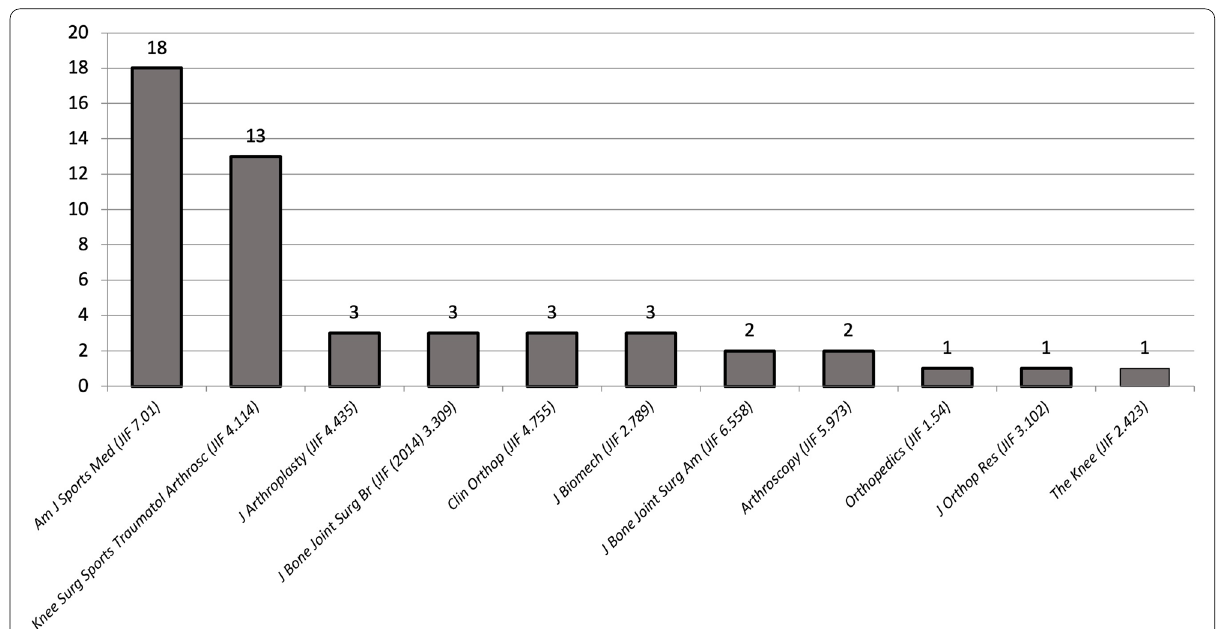
Fig. 2 Distribution of the top 50 studies by the journals of publication and their Journal Impact Factor of 2021 (JIF). American Journal of Sports Medicine (Am J Sports Med), Knee Surgery, Sports Traumatology, Arthroscopy (Knee Surg Sports Traumatol Arthrosc), Journal of Arthroplasty (J Arthroplasty), Journal of Bone and Joint Surgery, American Volume (J Bone Joint Surg Am), Journal of Bone and Joint Surgery, British Volume (J Bone Joint Surg Br), Clinical Orthopaedics and Related Research (Clin Orthop), Journal of Biomechanics (J Biomech), Journal of Orthopedic Research (J Orthop Res)